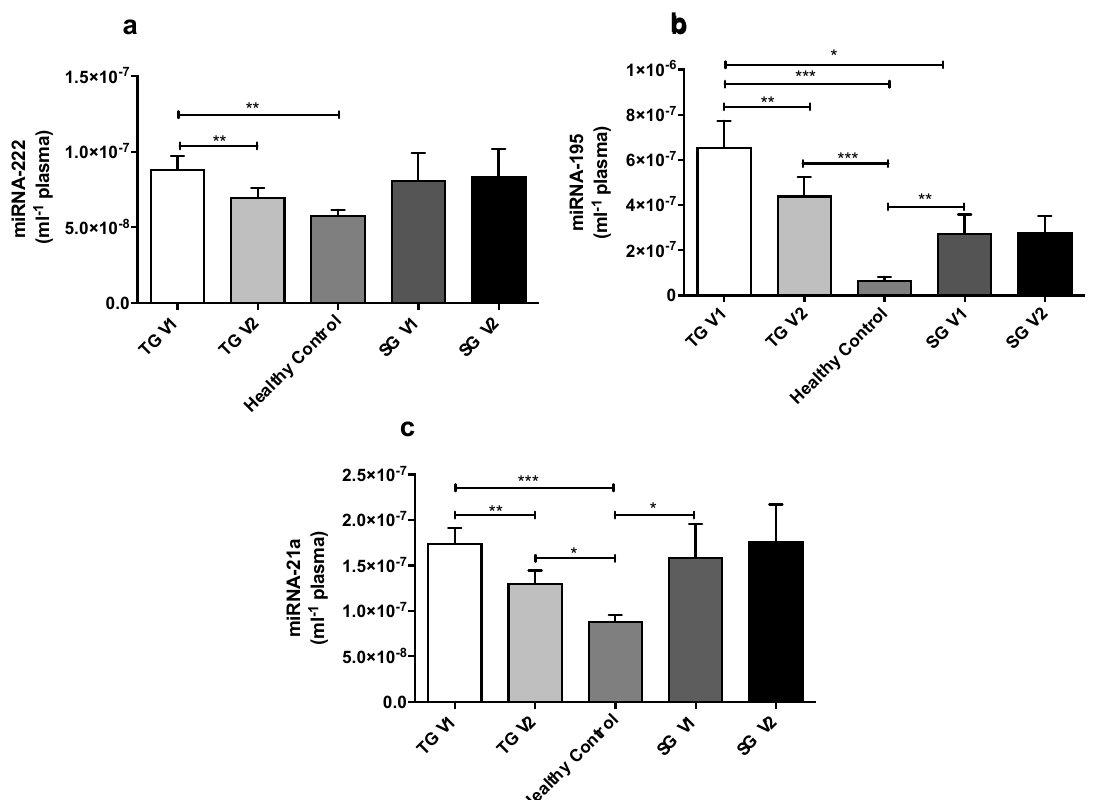
Figure 1. ( a – c ) A comparison of miR-222, miR-195 and miR-21a levels in plasma for all groups. At baseline (TG V1), miR-222, miR-195 and miR-21a levels were significantly upregulated in the TG compared to healthy controls (CG). The levels of miR-222, miR-195 and miR-21a were all significantly reduced in the TG after metformin therapy (TG V2). The results are presented as the mean ± SEM. Within the TG and SG, the comparison was analyzed using the paired Student t -test. An unpaired Student t -test was used to compare the healthy controls and patients’ groups. Treatment group pre-metformin (TG V1), treatment group post-metformin (TG V2), standard group pre-observation (SG V1) and standard group post-observation (SG V2). * p < 0.05, ** p < 0.01, *** p < 0.001.